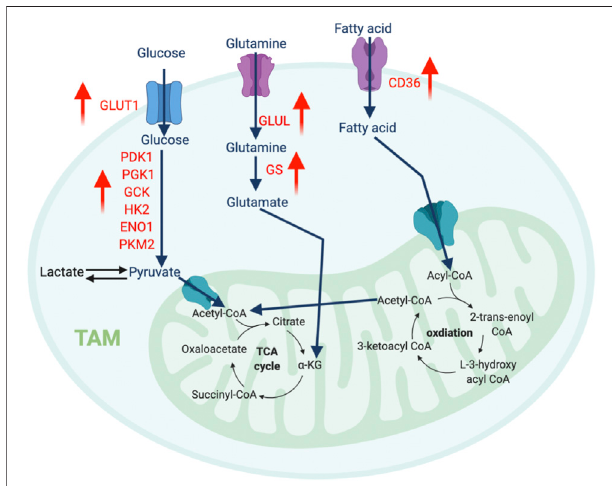
FIGURE 3 | The metabolic features of TAM. The tumor-in fi ltrating TAMs upregulate glycolysis pathway to regulate their migration and pro-metastatic capability, while promote amino acid and fatty acid metabolism to support their immunosuppressive function. “ ↑ ” indicates “ increase. ” PDK1, Pyruvate Dehydrogenase Kinase 1; PGK1, Phosphoglycerate Kinase 1; GCK, Glucokinase; HK2, Hexokinase 2; ENO1, Enolase 1; PKM2, Pyruvate kinase isozymes M1/M2; GLUT1, Glucose transporter 1; GLUL, Glutamate- Ammonia Ligase; GS, Glutamine synthetase.